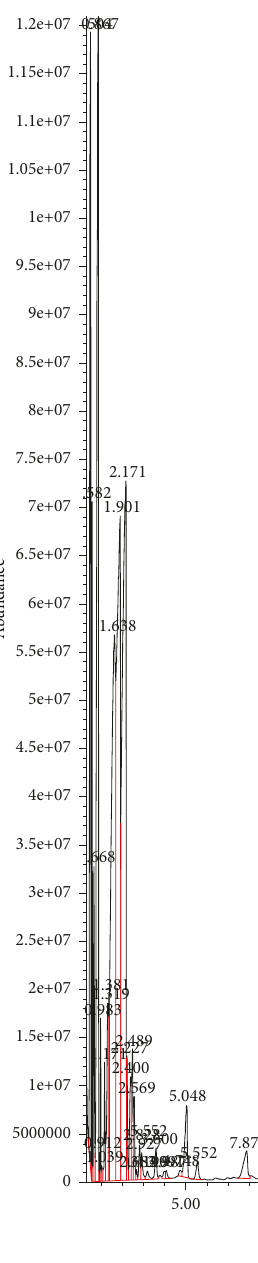
Figure 2: Gas chromatography of Mentha suaveolens